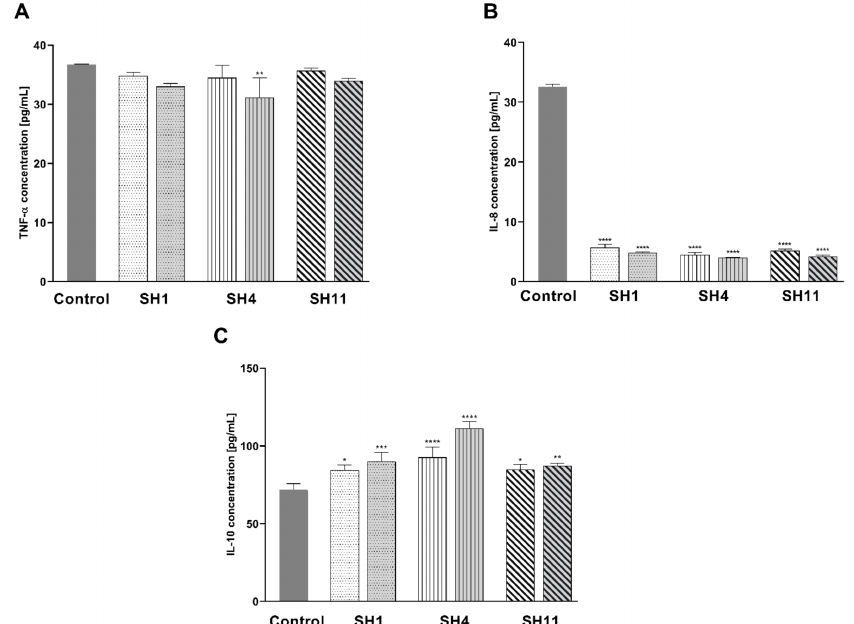
Figure 8. Concentrations of pro-inflammatory cytokines TNF- α ( A ) and IL-8 ( B ), and anti- inflammatory cytokine IL-10 ( C ) in MCF-7 human breast cancer cells after 24-h incubation with SH1 and SH4 at concentrations of 600 µ g/mL and 800 µ g/mL and SH11 at concentrations of 200 µ g/mL and 400 µ g/mL. Results are presented as mean ± SD from three experiments performed in duplicate. Statistical significance was calculated using one-way ANOVA with Bonferroni multiple compari- son test. Differences were considered statistically significant at **** ( p ≤ 0.0001), *** ( p ≤ 0.0005), ** ( p ≤ 0.005), and * ( p ≤